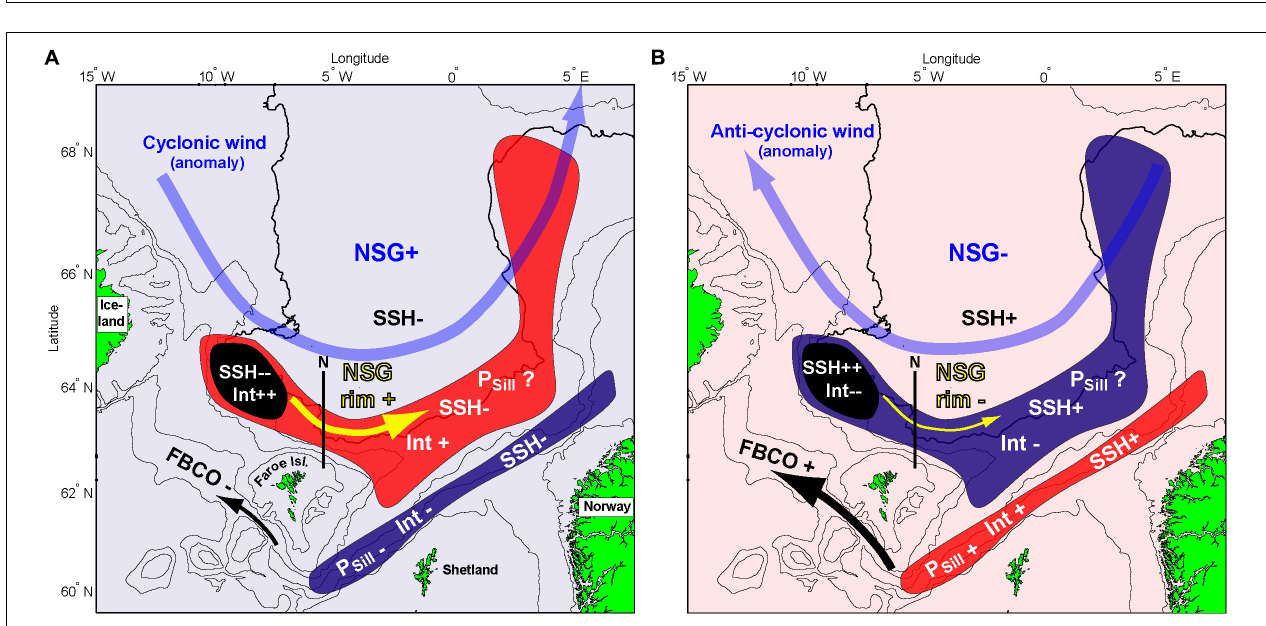
FIGURE 9 | Time series of the FBCO (red) and the sea-surface height (SSH) in the IFR-North region (yellow/white outline in Figure 8 ). The series have been detrended and running mean filtered over 360 days, in order to remove the seasonal signal.